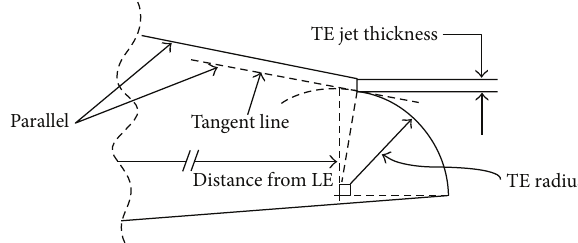
Figure 8: TE construction of the Coand˘a configured airfoil (the jet flow is tangential to the rounded circular